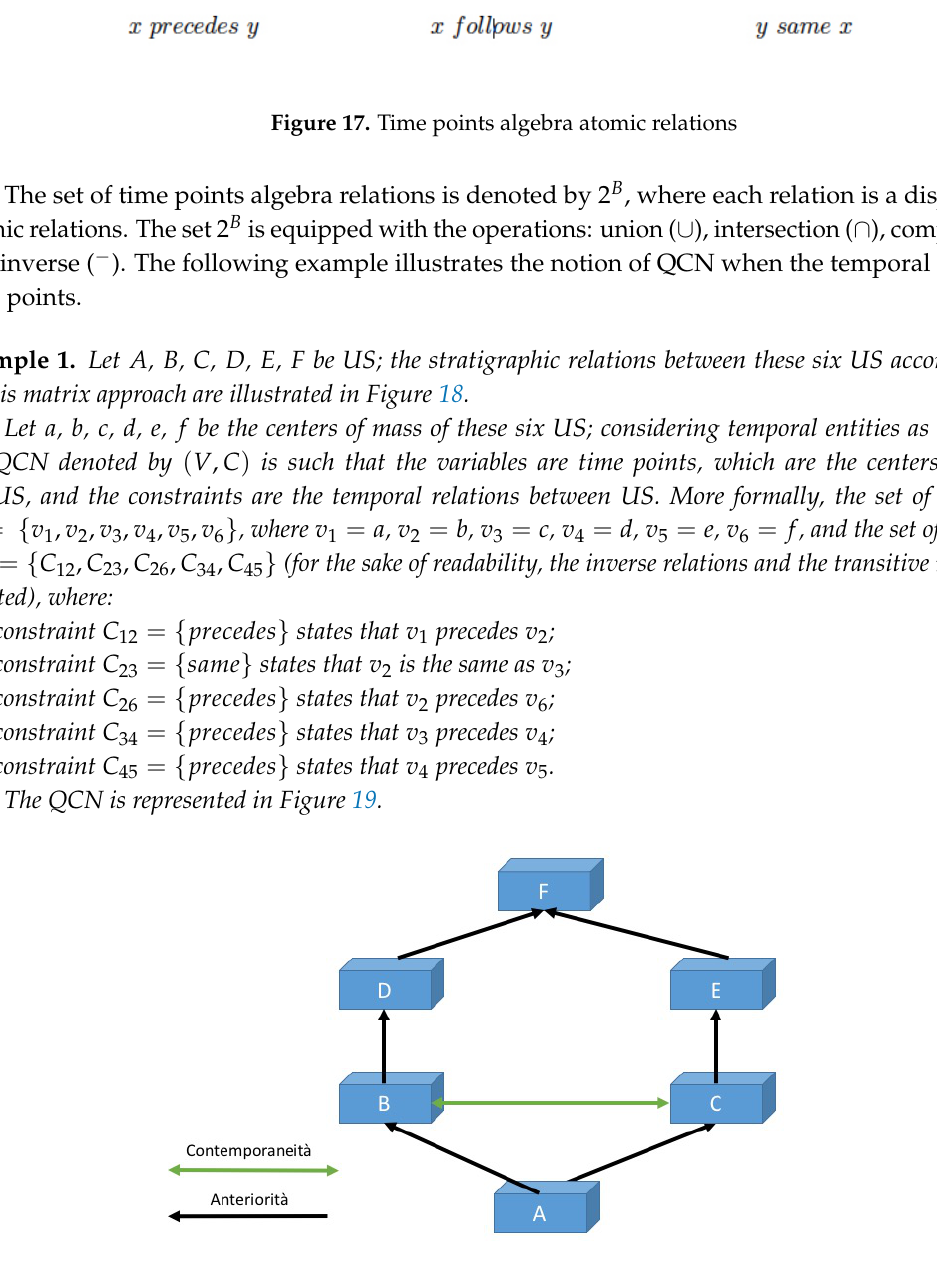
Figure 18. Example of relations between